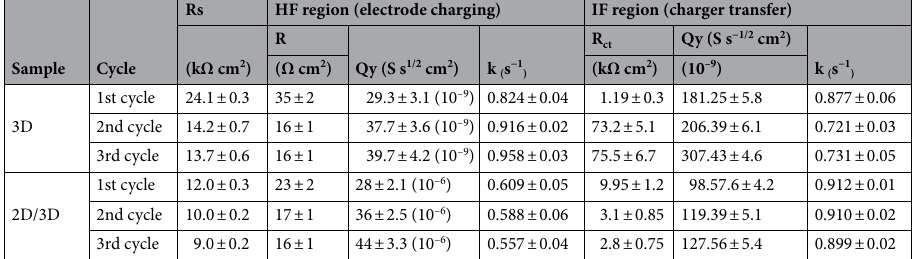
Table 3. The fitting parameters extracted using the EEC given in Fig. 4d. HF and IF stand for the high- frequency and intermediate-frequency, respectively.